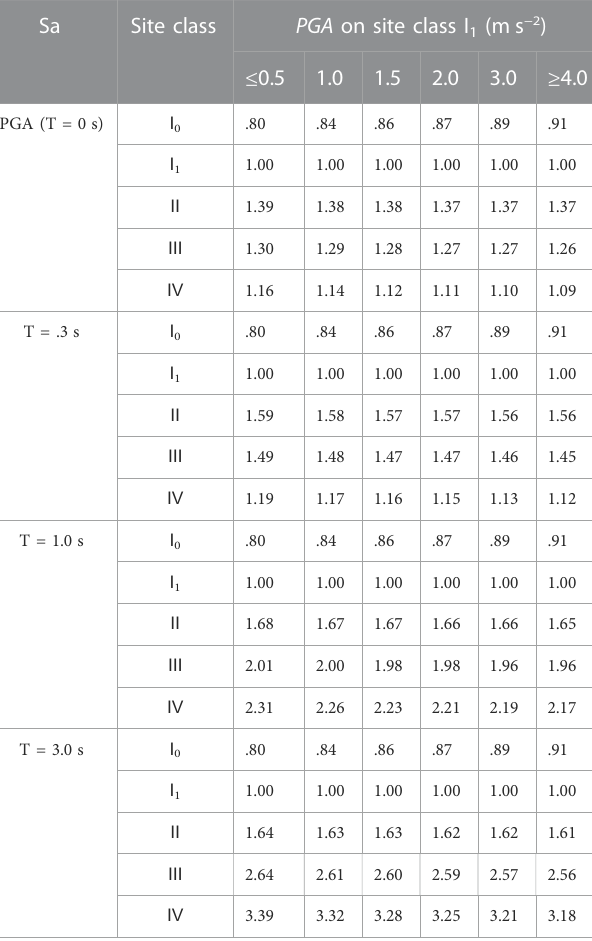
TABLE 5 Scaling ratios for Sa due to site conditions varying with PGA on site class I 1 . Sa Site